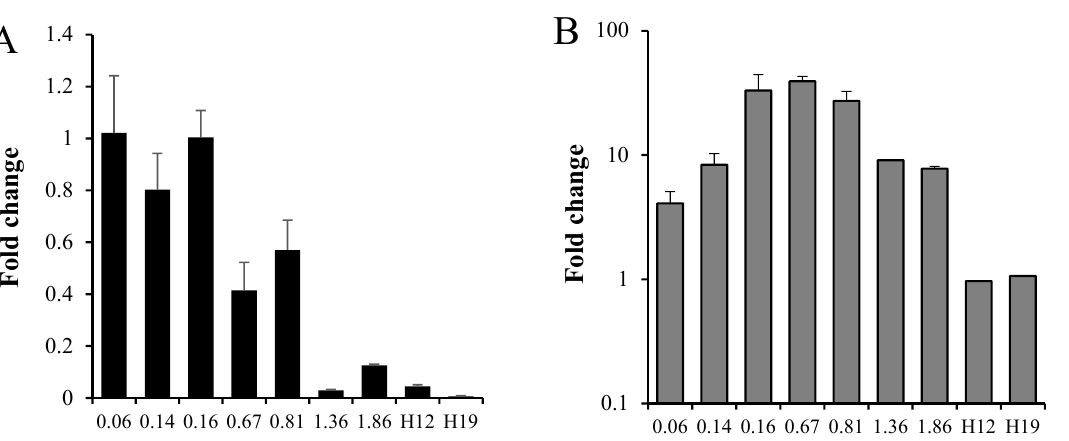
Figure 2. Role of growth phase on recA gene expression and induction by MX. A fresh culture of Mtb H37Rv was set up from early phase to stationary phase. At each optical density (OD) value indicated in the X-axis, culture aliquots were incubated with or without 2 × MIC (0.25 µ g/mL) of MX for 16 h. In parallel, hypoxic day 12 (H12) and day 19 (H19) Wayne dormancy cultures were treated with 2 × MIC of MX for 16 h in constant hypoxic conditions. At the end of each incubation period, total RNA was extracted and gene expression determined by qRT-PCR. Early log-phase cells: OD 0.06 and 0.14. Log-phase cells: OD from 0.16 to 0.81. Stationary phase cells: OD from 1.36 to 1.86. ( A ) Fold-change in recA gene expression compared to early log phase cells (OD of 0.06). ( B ) RecA fold-changes in Mtb H37Rv incubated for 16 h with 2 × MIC of MX compared to the corresponding growth phase untreated cells. An equal statistically significant difference between recA expression of MX-treated and untreated cells was observed for all aerobic conditions ( p ≤ 0.01) except for OD 1.86 ( p ≤ 0.02).